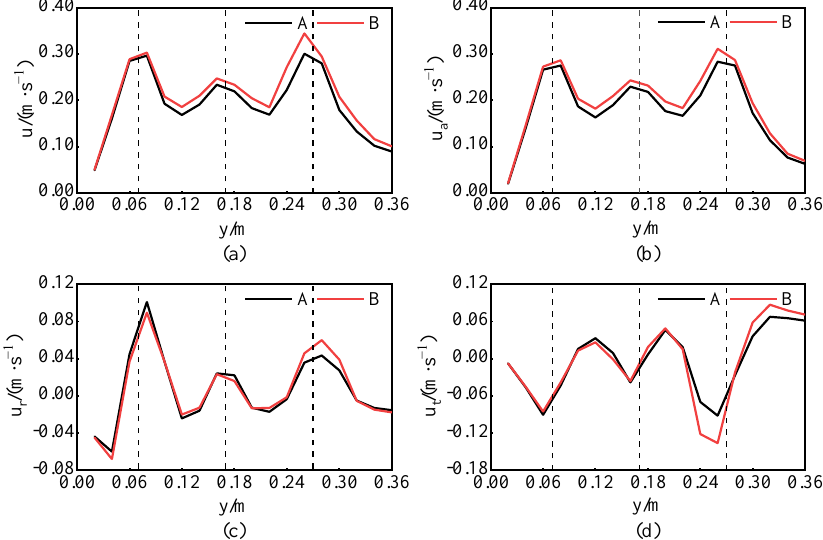
Figure 15. Velocity distribution at the radial position r = 90 mm when the medium is glycerol and Re = 55.5. The three dotted lines are the centerline positions of the three blades. ( a ) Total speed comparison; ( b ) Axial velocity comparison; ( c ) Radial velocity comparison; ( d ) Tangential velocity comparison.